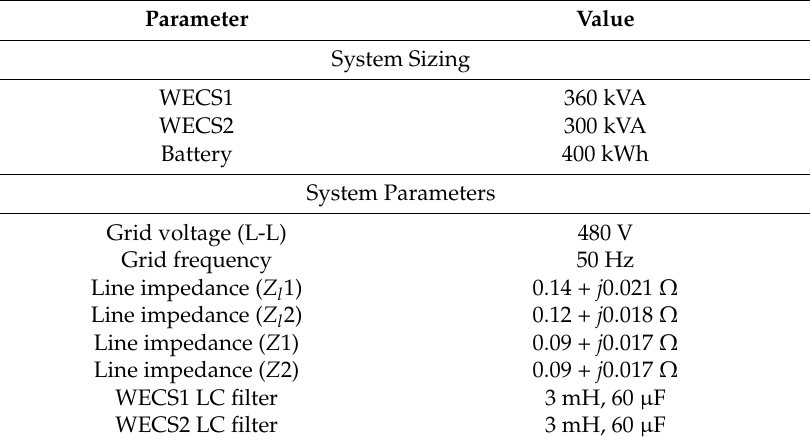
Table 2. System Sizing and